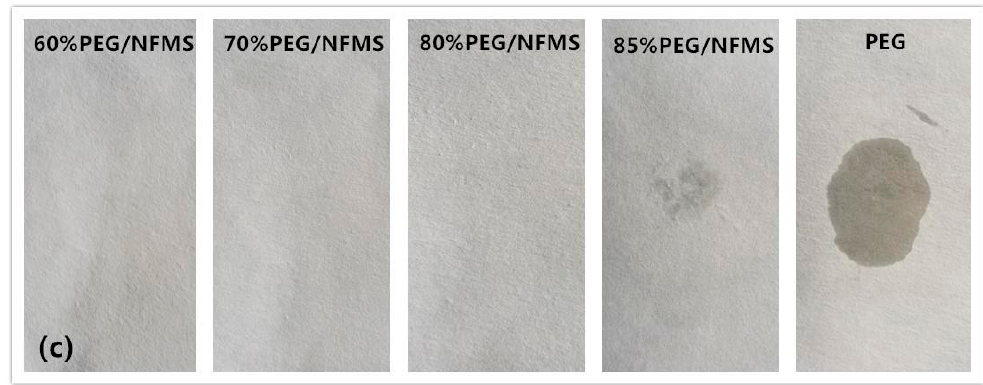
Figure 5. Photographs of leakage test of PEG/NFMS: ( a ) before the thermal stability test; ( b ) after the thermal stability test; ( c ) after removal of the samples.